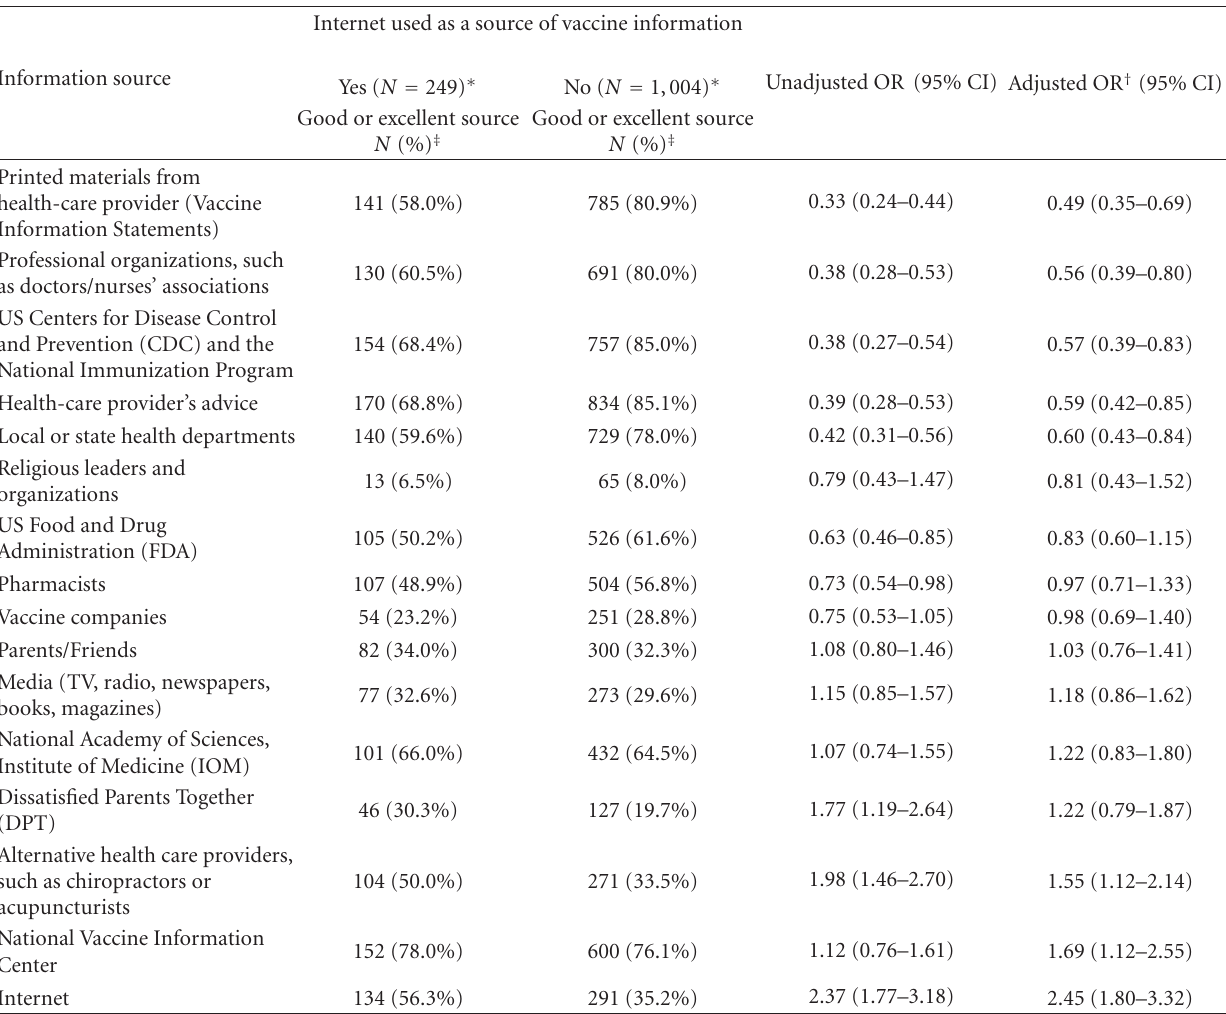
Table 1: Perceptions of vaccine information sources among parents who did or did not use the Internet for vaccine